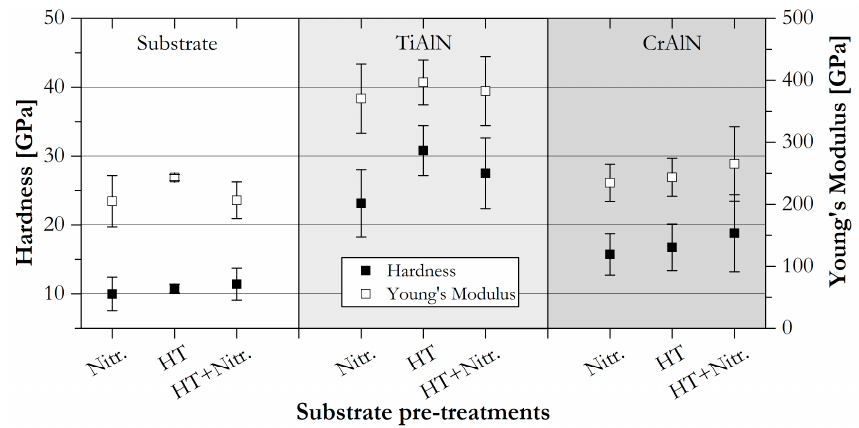
Figure 6. Hardness and Young’s modulus of the substrate after the pre-treatments and the coatings deposited on the different substrates.